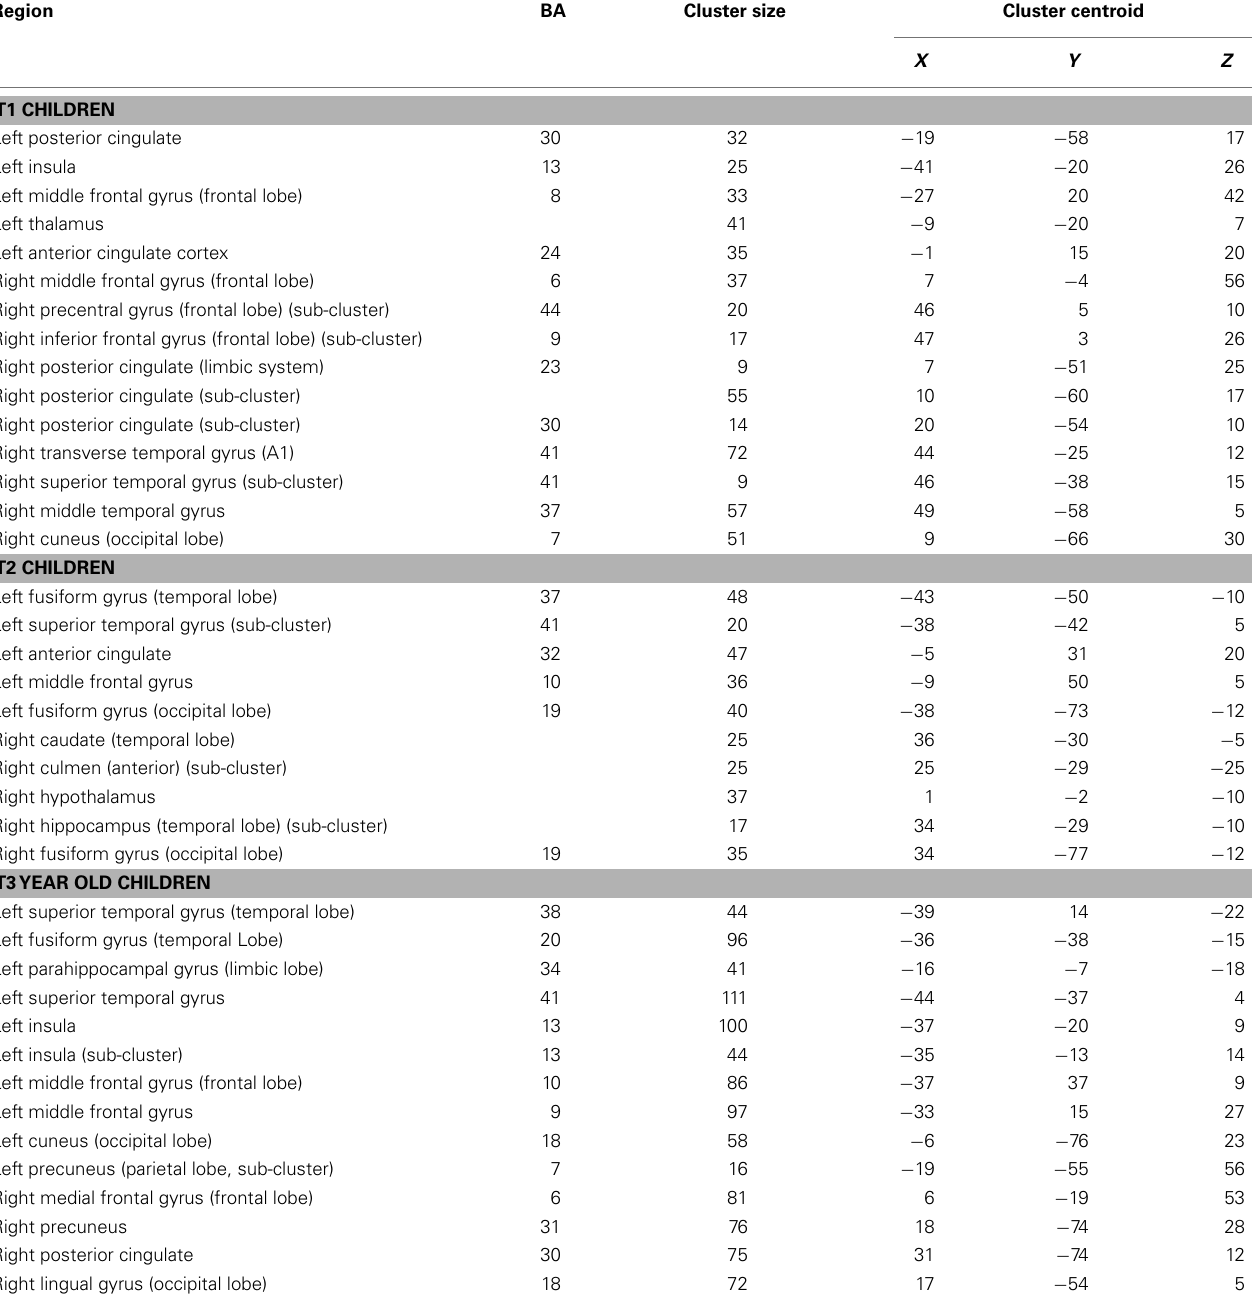
Table 2 | Regression analysis of MRI data from the verb generation task atT1,T2, andT3 participants with Letter–Word reading standard scores atT3